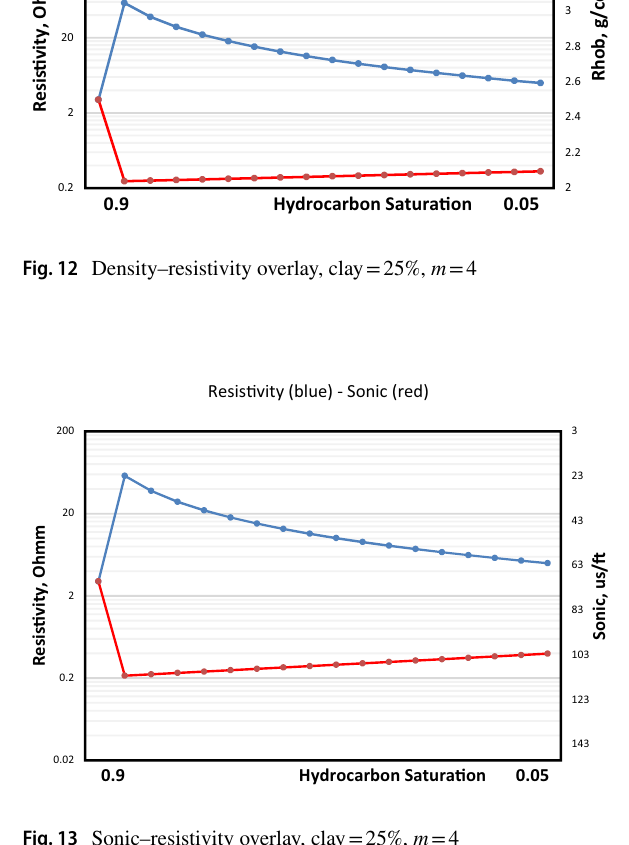
Fig. 13 Sonic–resistivity overlay, clay = 25%, m =